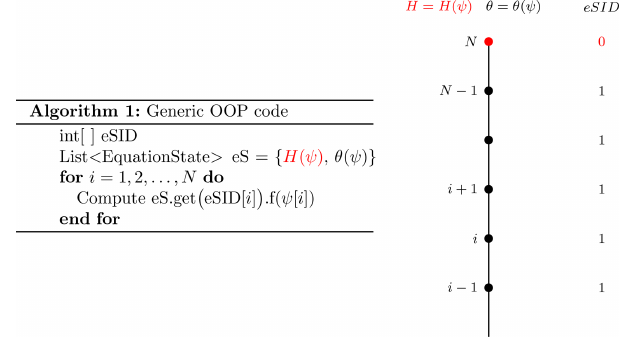
Figure 6. Adopting OOP with a generic programming approach, the computation of the equation states is independent from the grid. In fact, the behaviour of each control volume is determined by the vector eSID – equationStateID in the code – that determines which object belonging to the class EquationState of eS – equationState in the code – must be used to compute the equa- tion state. In this manner it is possible to traverse the computation domain without resorting to the if-else statement. Here the non- linear function V (ψ) is consistently replaced with either H(ψ) or θ(ψ) according to the position of the node. To keep the pseudocode short, H(ψ) and θ(ψ) stand for all the nonlinear functions used in the NCZ algorithm, and the method f stands for one of the methods defined in the class EquationState